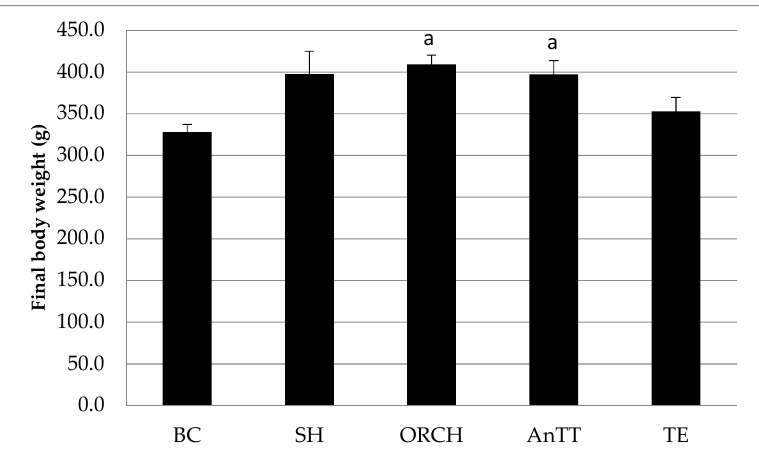
Figure 2. Final body weight of the rats. The data are shown as mean with standard error of the mean. Letter ‘a’ indicates significant difference versus the baseline group. Abbreviation: AnTT, annatto tocotrienol-supplemented group; BC, baseline control group; ORCH, orchidectomized group; SH, sham-operated; TE, testosterone enanthate-supplemented